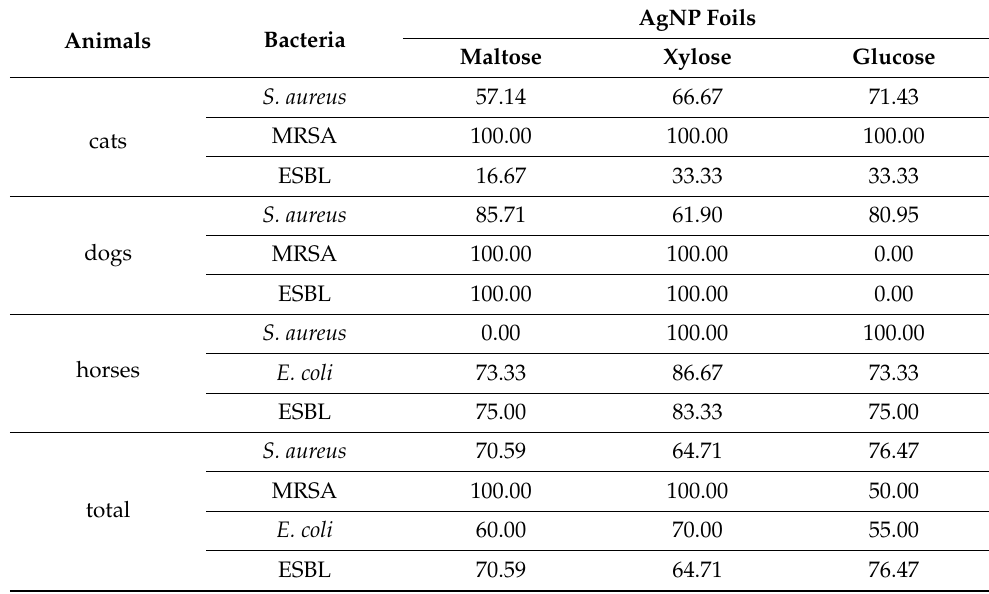
Table 2. Percentage (%) of bacterial isolates, whose growth was inhibited by the AgNPs.